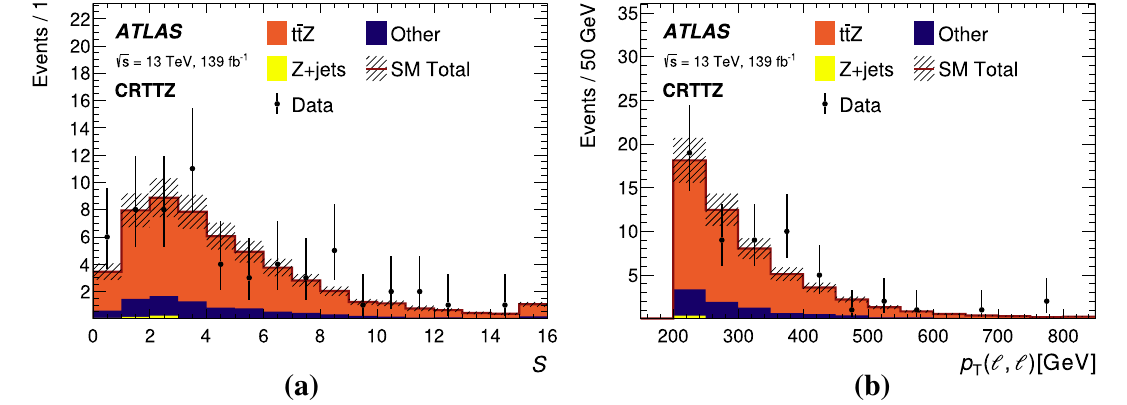
Fig. 5 Distributions illustrating the level of agreement between data (points) and the SM expectation (stacked histograms, after simultane- ously fitting to all backgrounds) in the t ¯ t + Z control region: a S and b p T ((cid:13),(cid:13)) for CRTTZ. The hatched uncertainty band around the SM